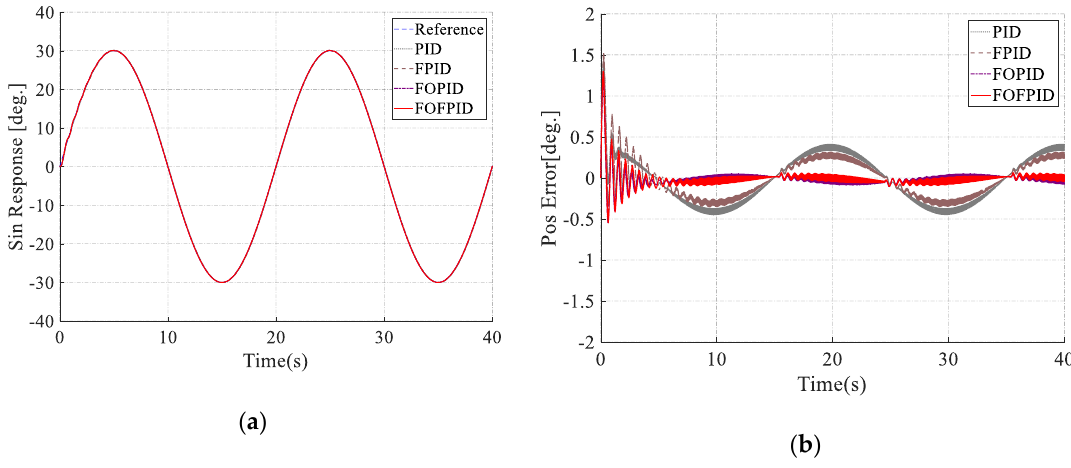
Figure 10. Comparison for 0.05 Hz sinusoidal trajectory (the payload is 50 N). ( a ) Output performance; ( b ) error effort.